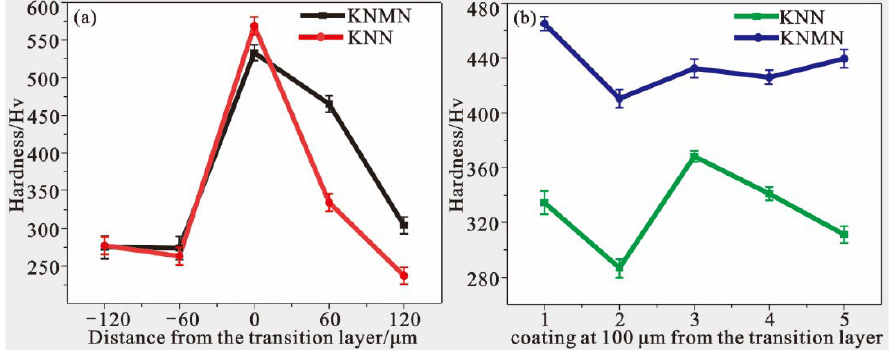
Figure 9. ( a ) Microhardness of KNN and KNMN transition layer to coating. ( b ) Average hardness of KNN and KNMN coatings.